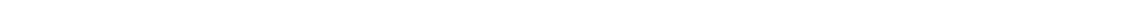
Fig. 7 The fate of uaKT-localized Stu1 and Slk19 after capturing of the uaKT. a – c Genotypes of the used strains are listed in Supplementary Table 1. uaKTs were produced in metaphase arrested cells as in Fig. 2 and cells were observed at the indicated timepoints after KT reactivation. Blue arrowheads indicate an uaKT. Bar, 2 µ m. a , c Statistics, see Supplementary Table 3. a After capturing of an uaKT Stu1 and Slk19 at least partially dissociate from KTs and colocalize as clusters on the capturing MTs. Only capturing events with at least two Stu1 signals on the capturing MT were quanti fi ed. b Stu1 clusters deposited after capturing are transported to the SPB along the capturing MT. c During the lateral transport of a captured KT a cluster of Stu1 predominantly localizes between the KT and the MT plus end and frequently overtakes the KT shortly before the KT reaches the SPB. Events were analyzed only if the capturing occurred ≥ 1 µ m distal to the SPB. Error bars represent the SD of two independent